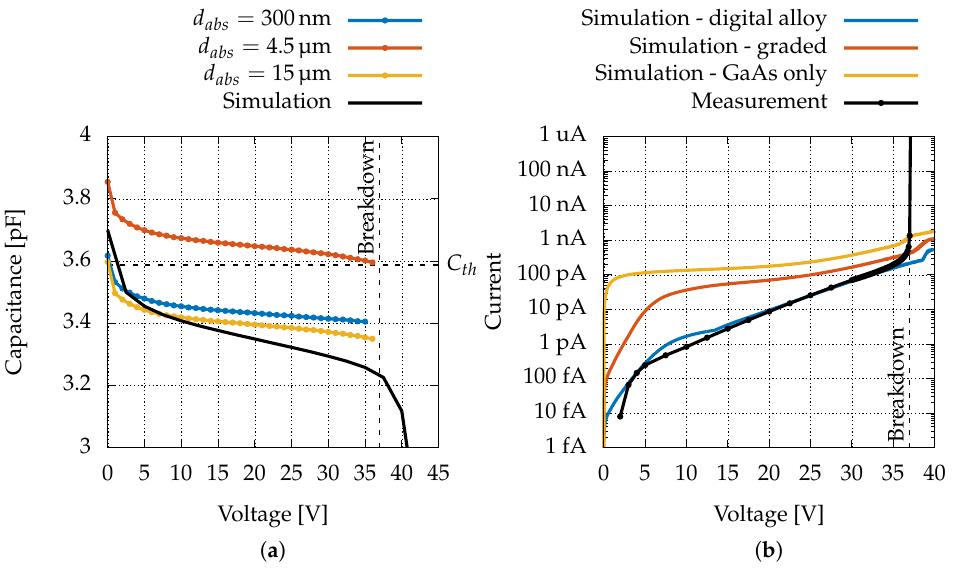
Figure 4. ( a ) C-V simulation obtained with Sentaurus TCAD software suite, C-V measurement of devices with different absorption region thicknesses and theoretical capacitance ( C th = 3.59 pF ) of a a parallel-plate capacitor. ( b ) Dark I–V curves obtained with different models of the multiplication